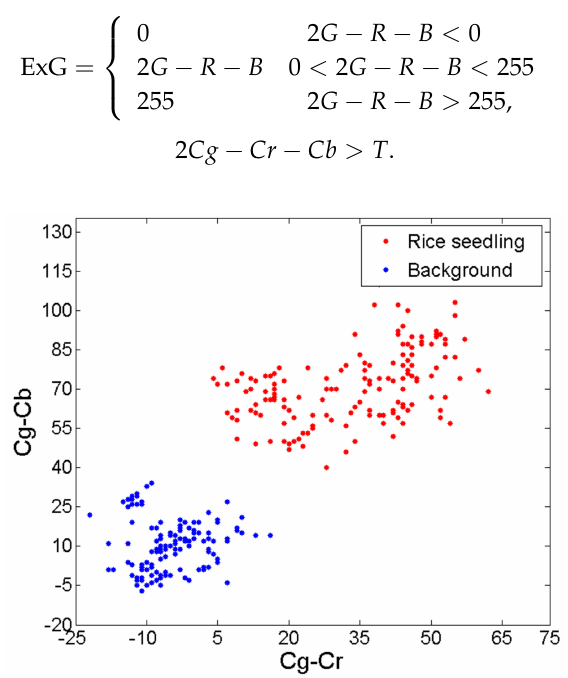
Figure 5. Relationship between Cg-Cr and Cg-Cb of the rice seedling and background sampling points.